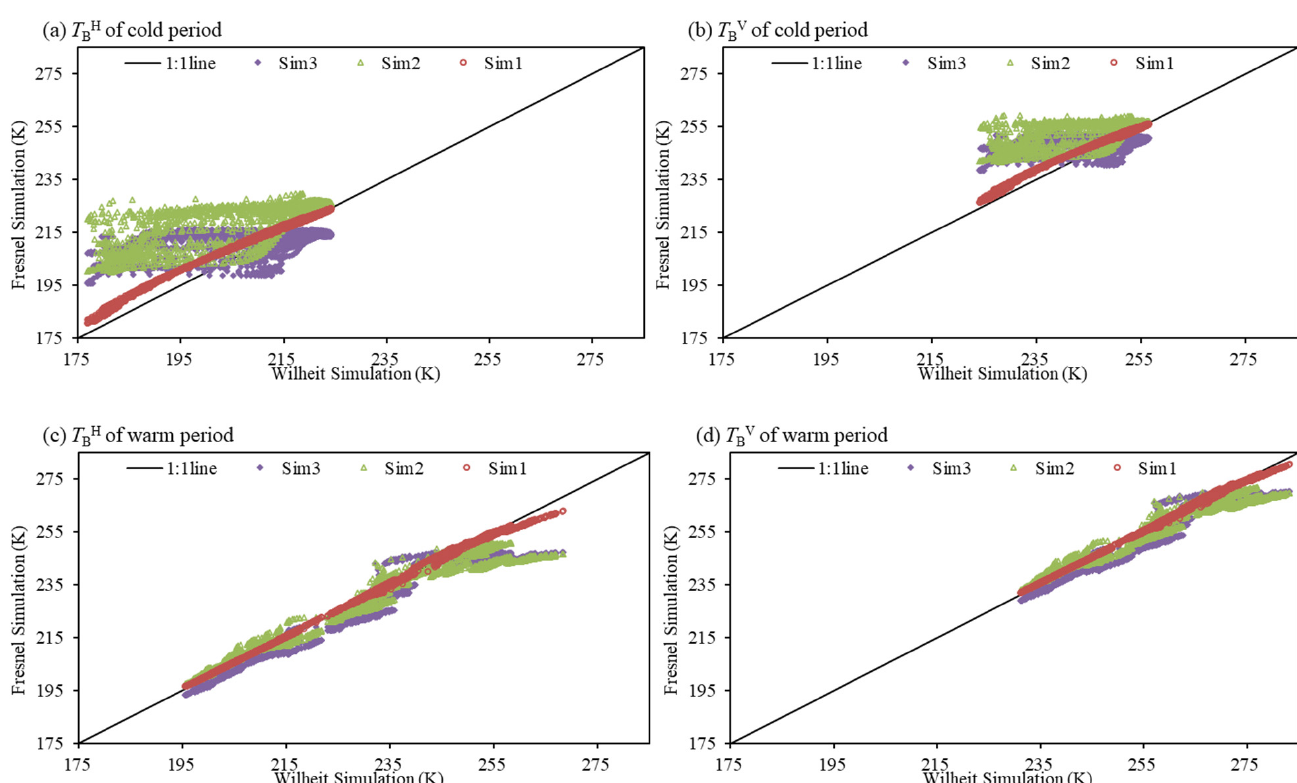
Figure 4. Comparisons of T BH ( a , c ) and T BV ( b , d ) simulations produced by the τ - ω model configured either with the multilayer Wilheit [12] model or with the single Fresnel model considering three depths of SMST profile at 2.5 (Sim1), 5 (Sim2), and 10 cm (Sim3) for ( a ) cold (from 1 January to 15 March) and ( b ) warm (from 7 August to 30 September) periods. The figure is modified from Wu [63].